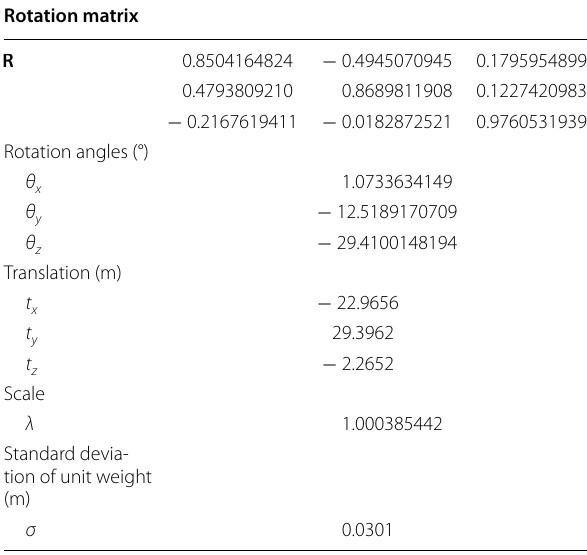
Table 7 Computed dual quaternion by ADQA Quaternion